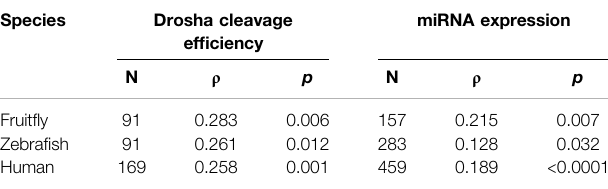
TABLE 3 | Correlation between mGHG scores and miRNA cleavage or miRNA expression. Sample size (N), Spearman ’ s correlation coef fi cient ( ρ ), and P values are listed. Raw data are presented in Supplementary Tables S3-S5